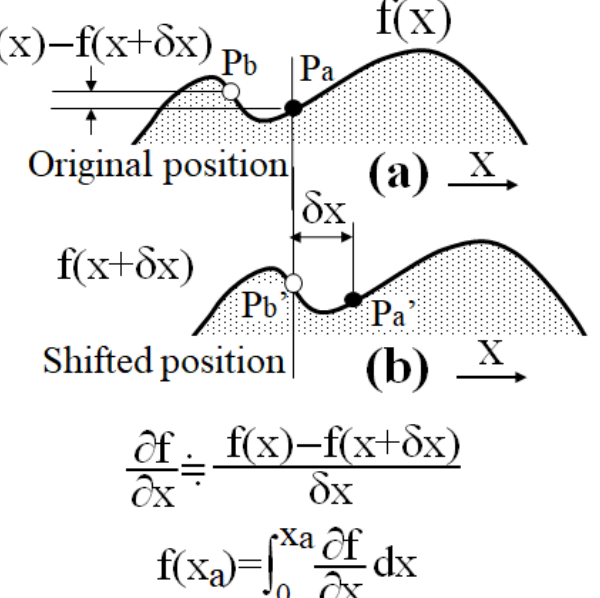
Figure 1. Principal of analyzing method: ( a ) Section of measured object at original position; ( b ) Section of measured object at shifted